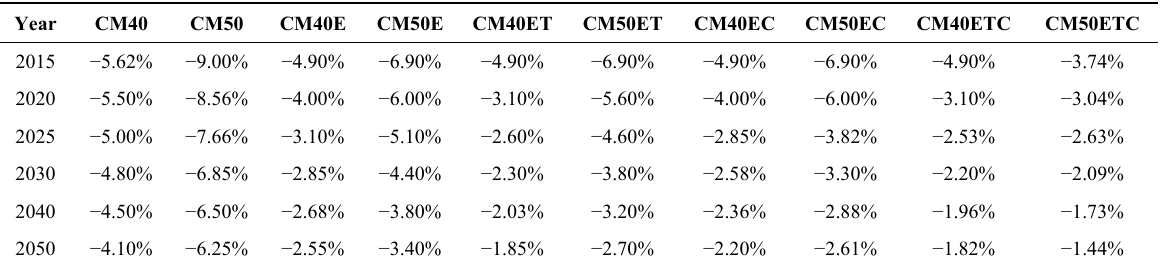
Table A5. Change of coal supply in 2050.